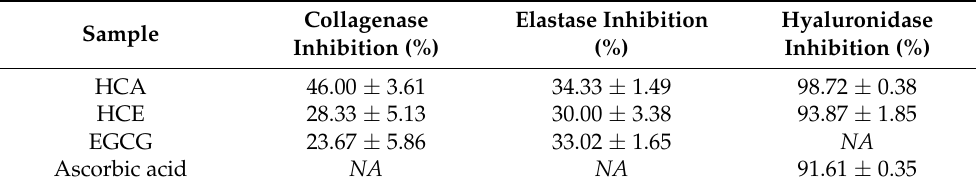
Table 2. Skin aging-related enzyme inhibitory effects of H. cordata extracts at 1 mg/mL.